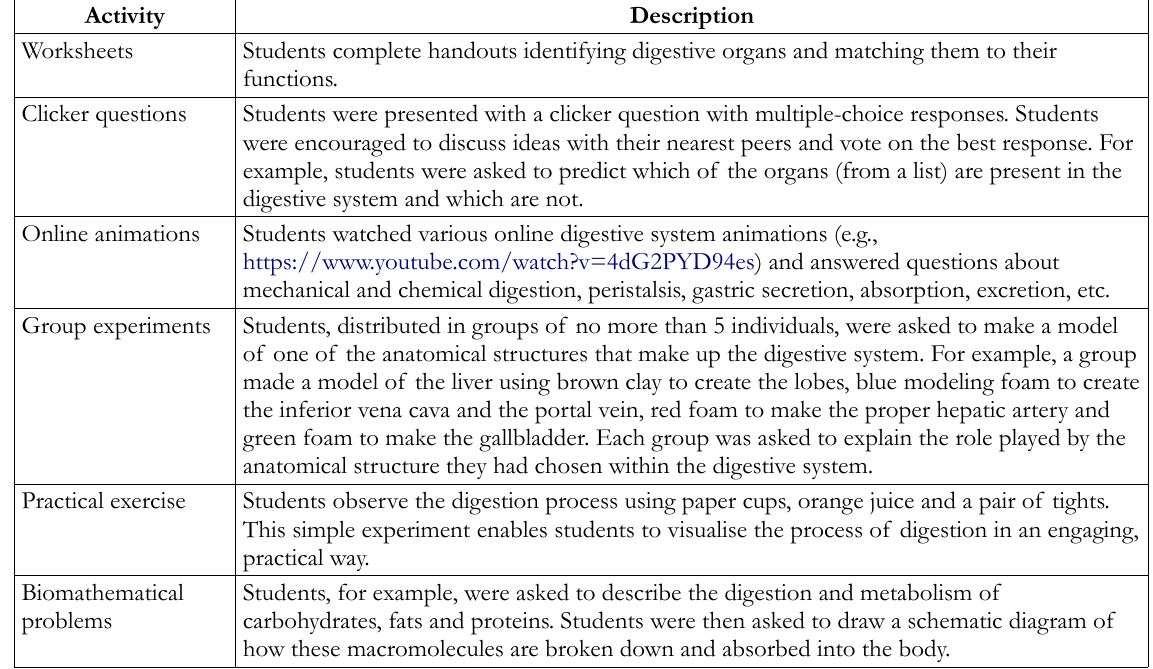
Table 1. Examples of in-class activities used in the flipped